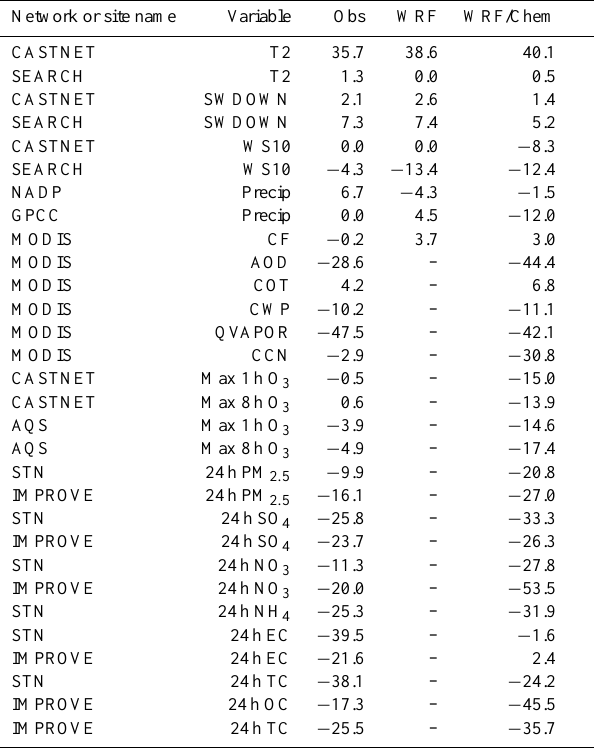
Table 2. Percentage changes in observed and simulated variables between 2010 and